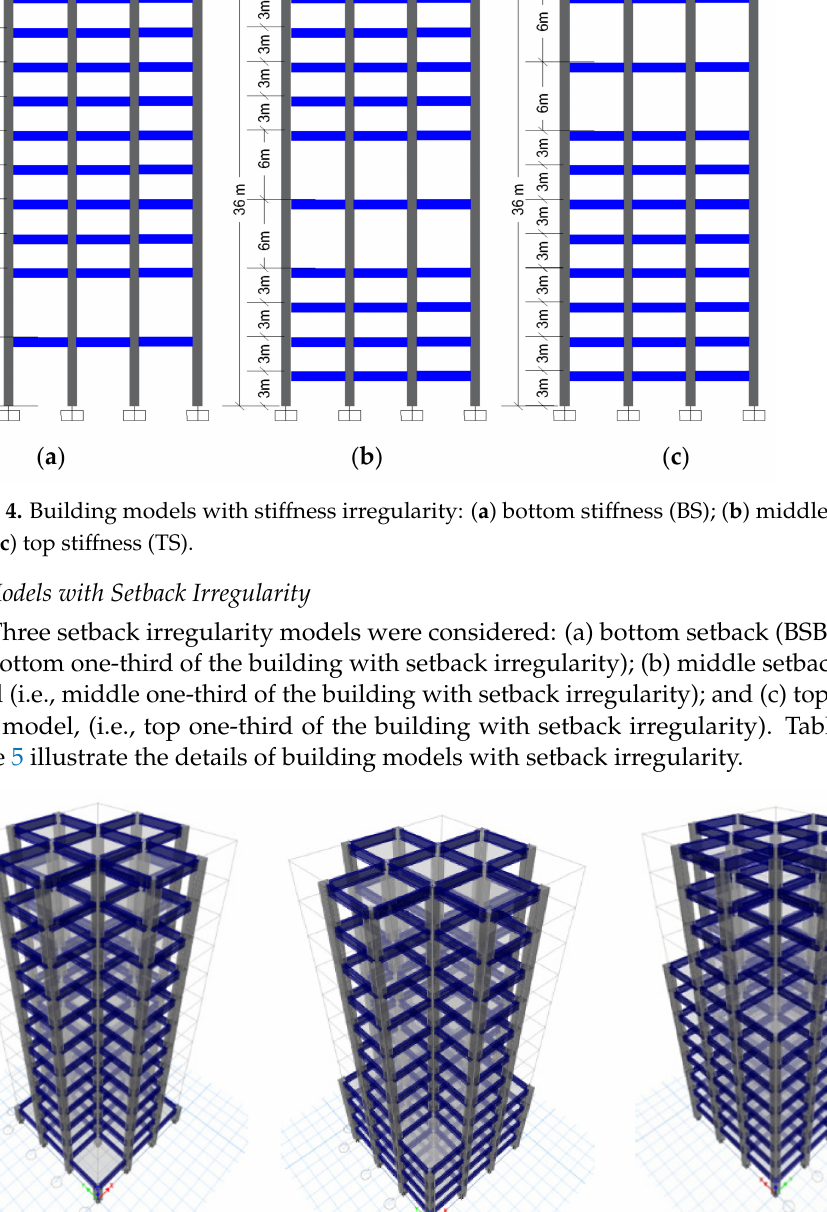
Figure 5. 3D-models with setback irregularity: ( a ) Top Setback (TSB); ( b ) Middle Setback (MSB); ( c ) Bottom Setback